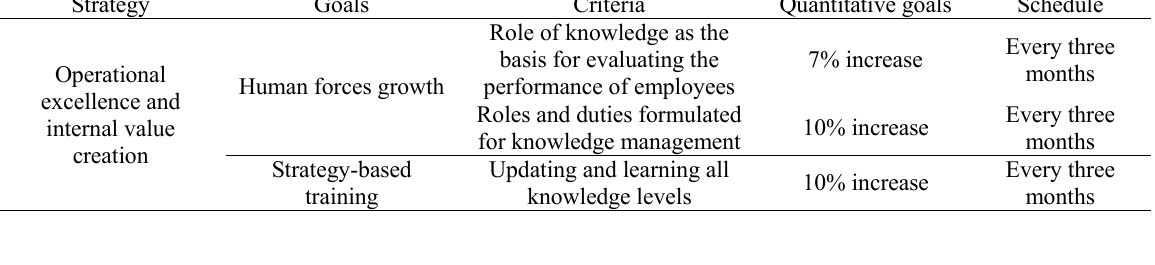
BSC for the learning and growth dimension in knowledge management evaluation in petrochemical